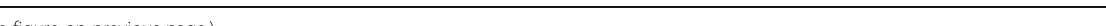
(See figure on previous page.) Fig. 6 Assay of antimicrobial properties of AuNPs on pathogenic bacteria, fungi, and multi-drug-resistant (MDR) bacteria. a , f Plates and corresponding graphs showing disc-diffusion assay of the nanoparticles with increasing inhibition zones for E. coli . Inhibition zones obtained in similar assays with b , g Agrobacterium tumefaciens . c , h Magnaporthe oryzae . d , i MDR E. coli . e , j MDR A. tumefaciens . All experiments were done with increasing amounts of AuNPs on paper discs; clock-wise from top: 0.249 μ g (20%), 0.498 μ g (40%), 0.747 μ g (60%), 0.996 μ g (80%), and 1.245 μ g (100%) of AuNPs. Data are means±SE of three replicates. Different letters indicate statistically significant differences among the samples ( P <0.05, Tukey ’ s HSD test). Effect of AuNPs on the growth curve of k E. coli , l A. tumefaciens , m MDR E. coli , and n MDR A. tumefaciens . Asterisks indicate significant differences to control (Student ’ s t test, P <0.05). o